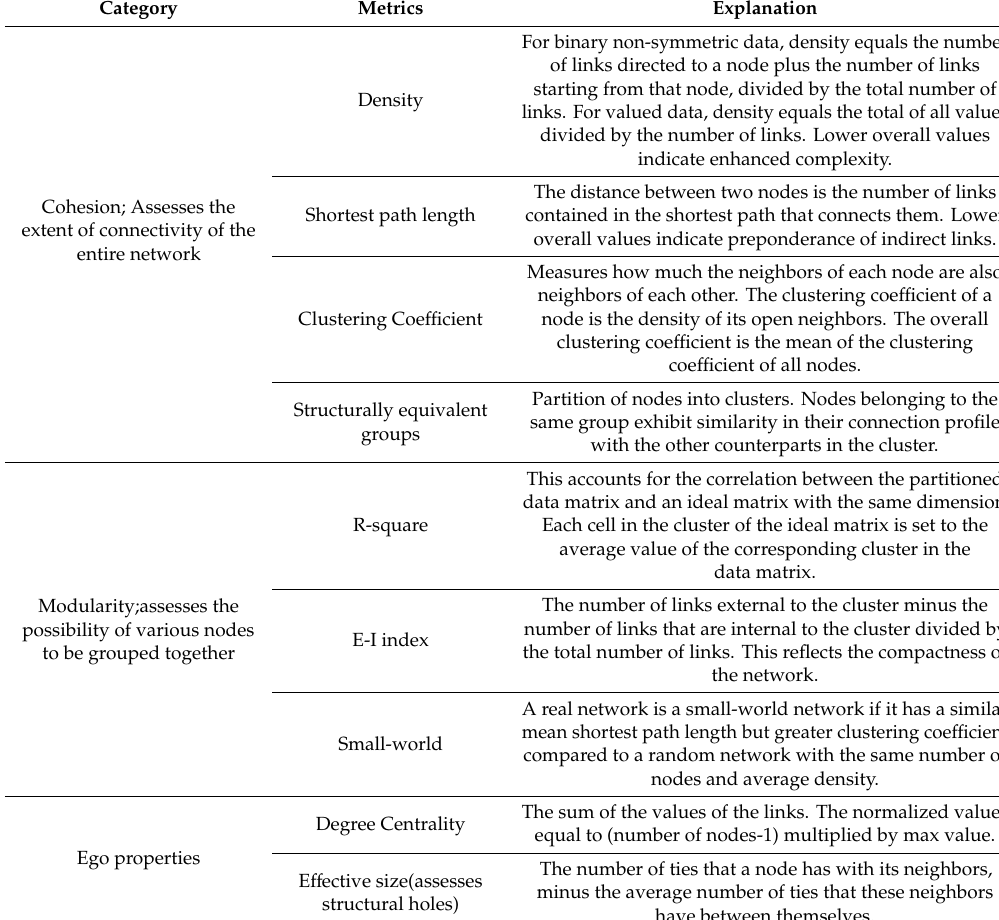
Table 1. A layout of the properties and metrics referring to the architecture of the network. Category Metrics